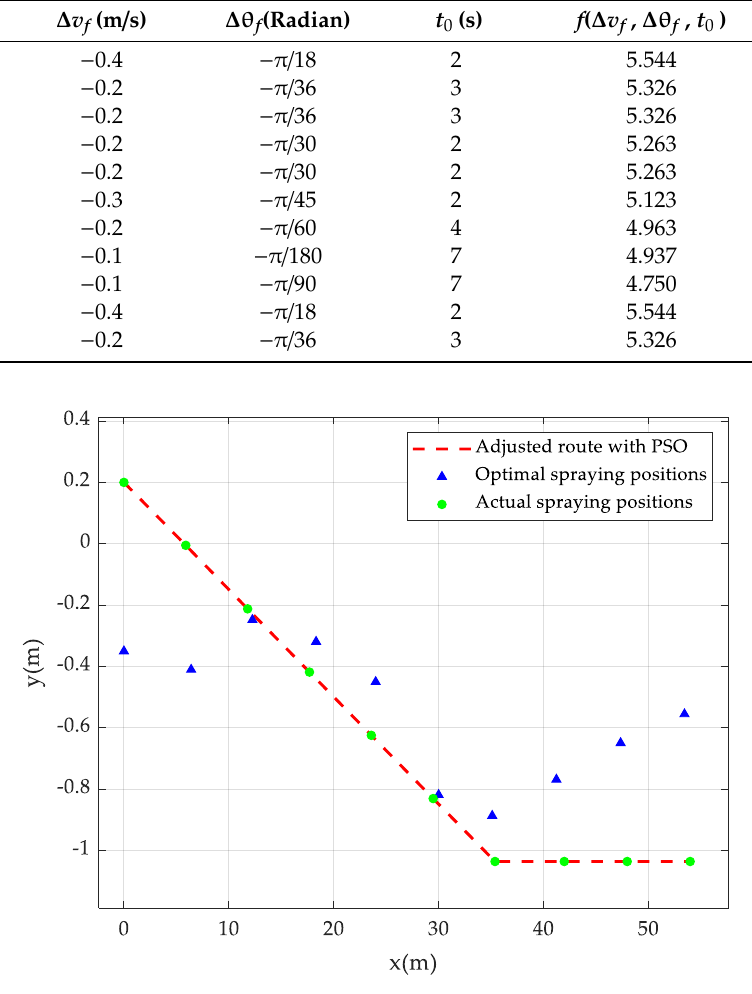
Figure 9. PSO-based UAV pesticide spraying trajectory adjustment.